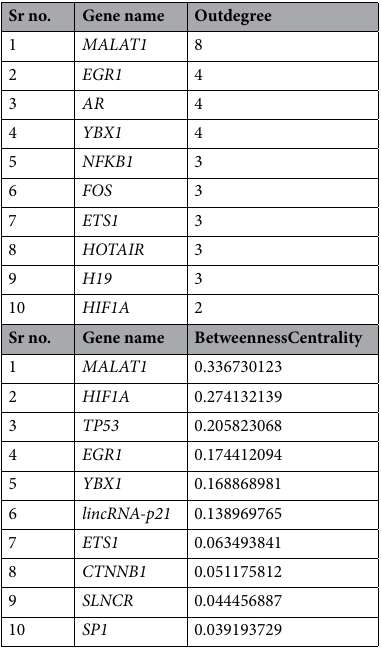
Table 3. Quantitative analyses of LncRNA-TFs-Gene (hub gene) regulatory network based on out-degree and betweenness